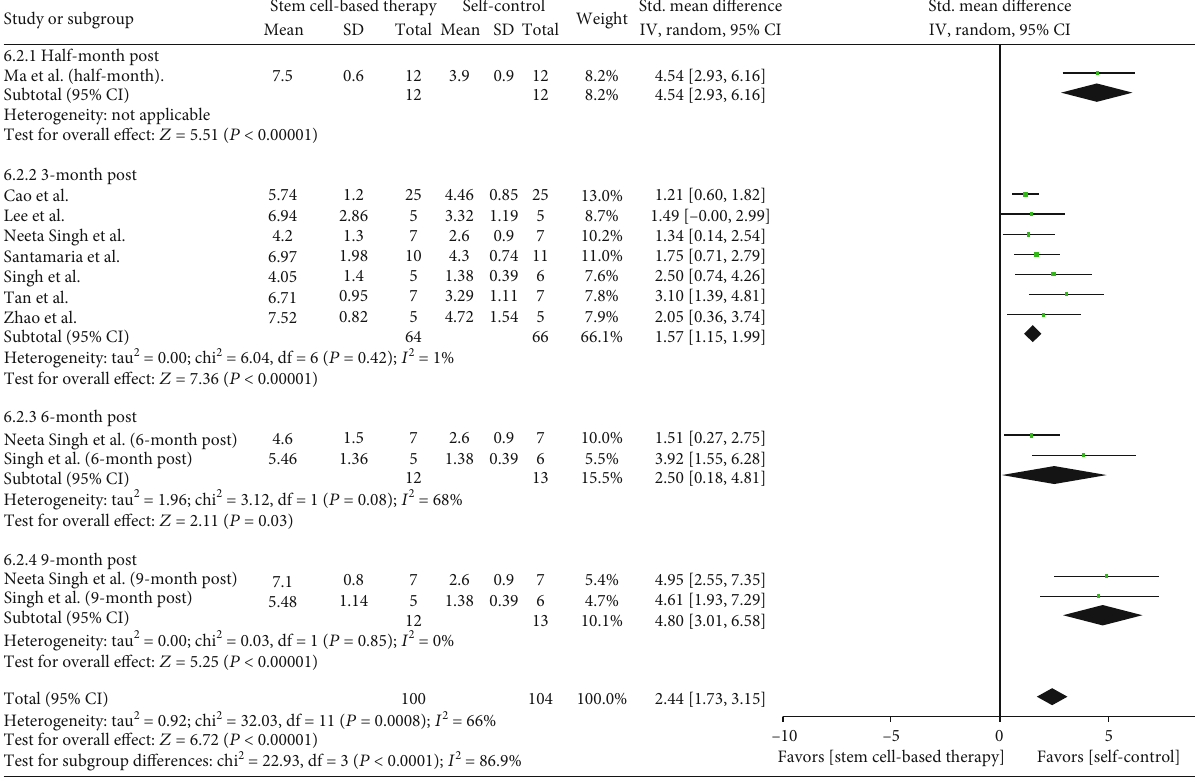
Figure 5: Subgroup analysis of endometrial thickness changes.